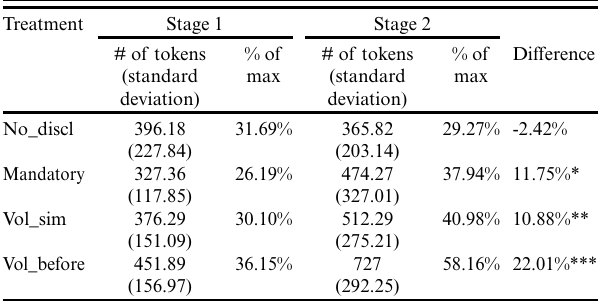
Table 2 . Summary statistics: mean group level contributions by stage and